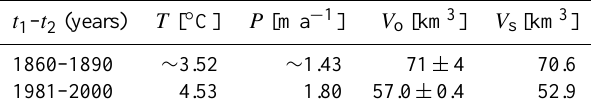
Fig. 10. (A) Steady state volume of the model glacier cor- responding to the 1860–1890 baseline climate ( 1T =0 ◦ C & 1P =0ma − 1 ; Table 4 and Fig. 6) and sensitivity of the model to step changes in T and P (the 1981–2000 baseline climate corresponds to 1T =1 ◦ C & 1P =0.37ma − 1 ). The dashed straight line shows the 2001 measured volume (57.0km 3 ). (B) Sensitivity to the rate factor A (in 10 − 15 s − 1 kPa − 3 ) and the sliding parameter C (in 10 − 15 ma − 1 Pa − 3 ). (C) Sensitivity to shift by one σ of ddf s and ddf i (in mm w . e . ◦ C − 1 d − 1 ). In (A) and (C) A =6.8 × 10 − 15 s − 1 kPa − 3 , C =0 (no sliding, method MI); in (A) and (B) ddf s =4.0mm w . e . ◦ C − 1 d − 1